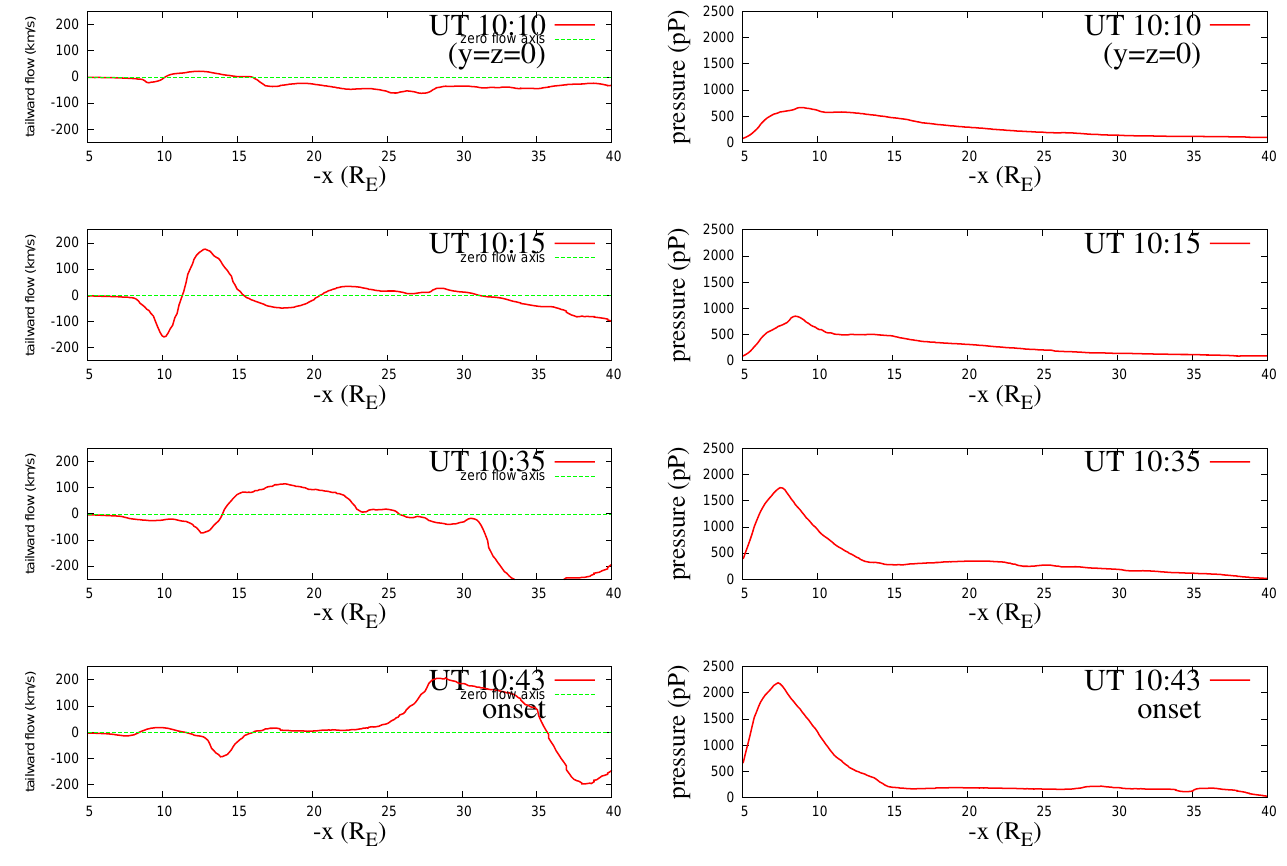
Fig. 3. Tailward flow (left column) and pressure (right column) profiles along line y = z = 0 at four time slices prior to the first aurora intensification. In the left column, the green dashed lines represent the zero horizontal axes.